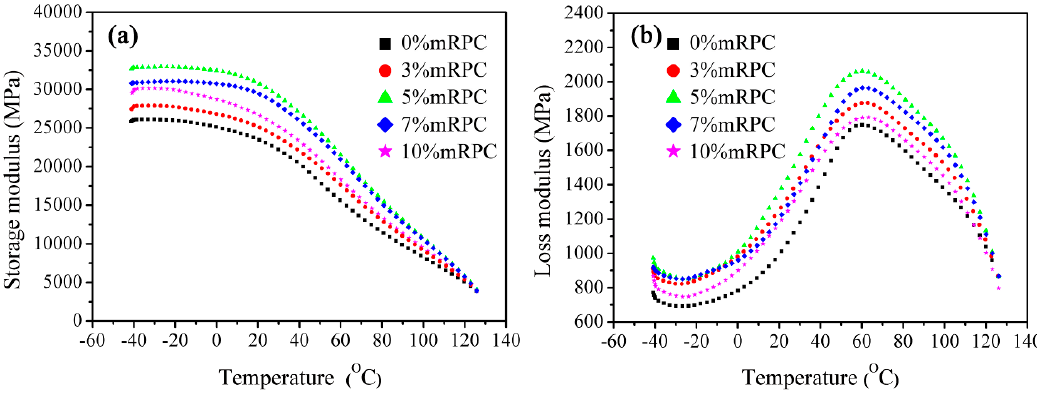
Figure 5. ( a ) Storage modulus and ( b ) loss modulus curves obtained for the mRPC/high-density polyethylene (HDPE)/wood fiber composites.